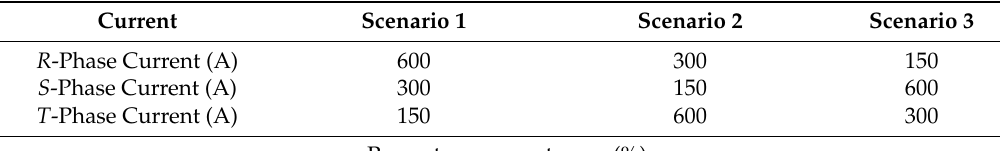
Table 8. Current errors of the proposed HCT when three-phase currents are